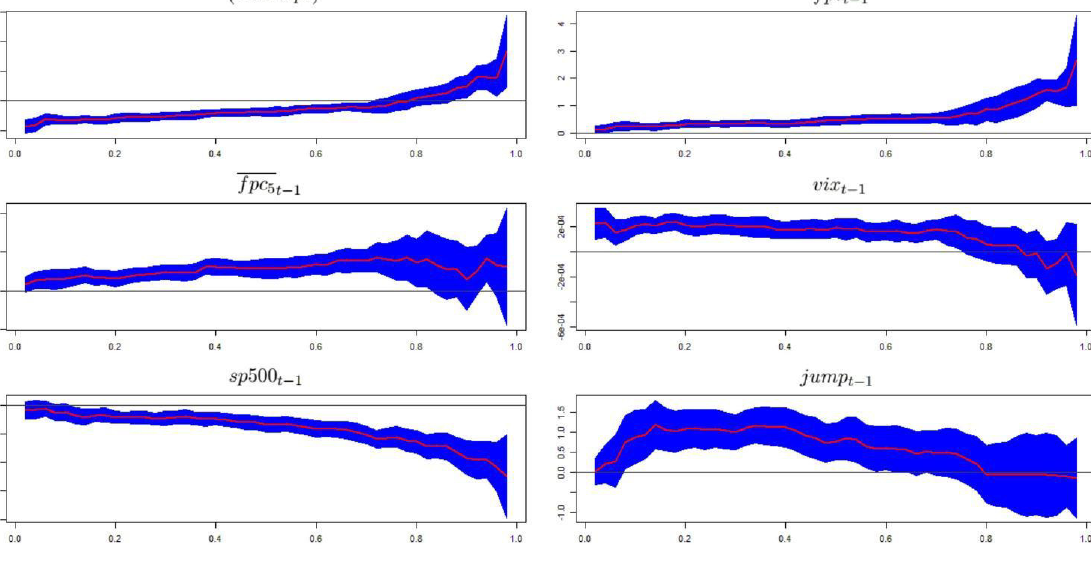
Figure 1. Coefficients plots. The red lines represent the coefficients values over τ levels, while the blue areas are the associated 95% confidence